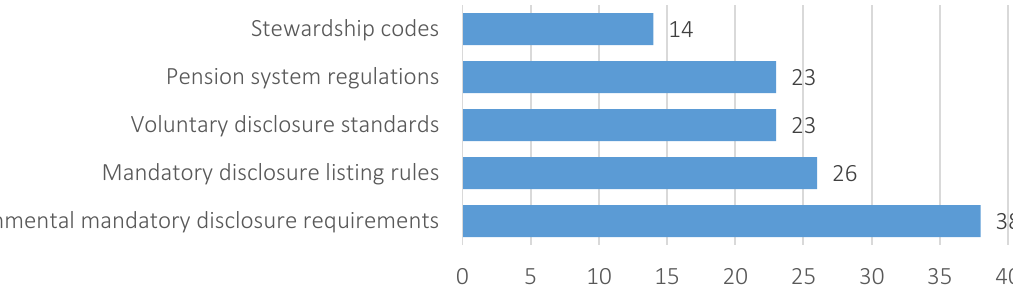
Figure 1. Standards distribution in the ESG investment sphere in the largest 50 countries in the world in